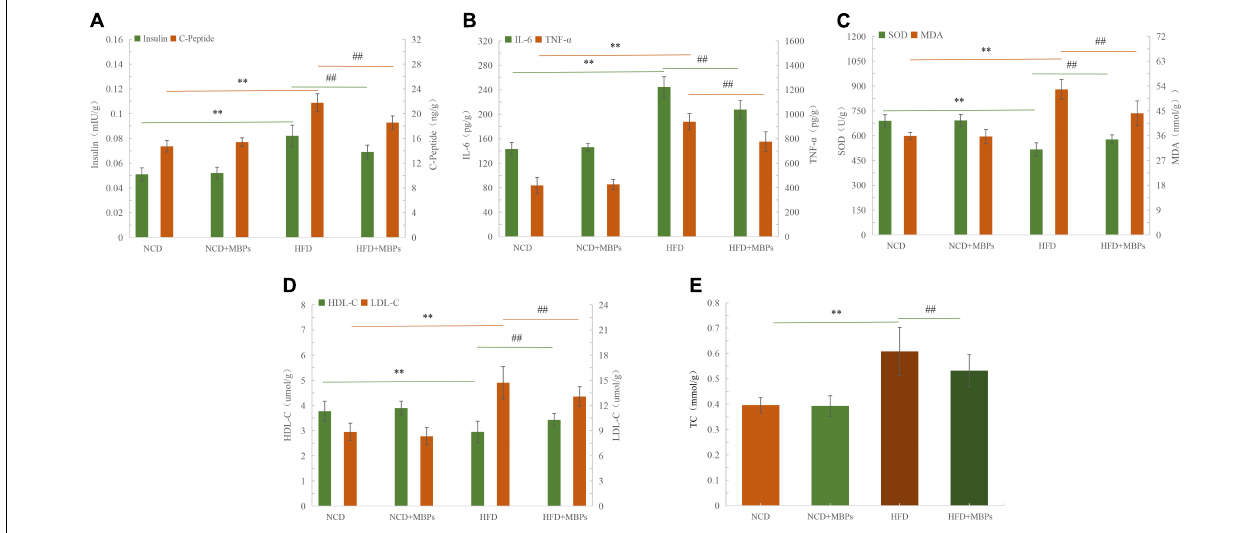
FIGURE 2 | The results of liver biochemical indexes in mice. Effects of MBPs on (A) insulin levels and C-Peptide levels, (B) IL-6 levels and TNF- α levels, (C) SOD levels and MDA levels, (D) HDL-C levels, and LDL-C levels, and (E) TC levels. Data were presented as the mean ± SD ( n = 6). ** P < 0.01, NCD compared with HFD mice. ## P < 0.01, HFD compared with HFD + MBPs